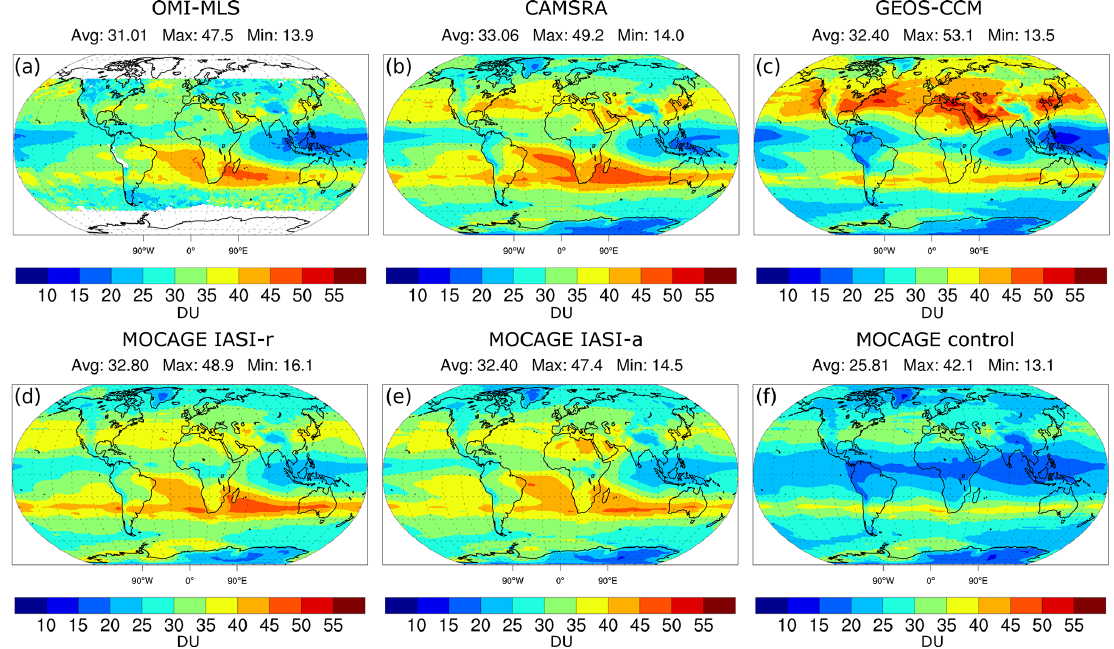
Figure 7. Tropospheric ozone column averaged over September–October–November 2010 from OMI-MLS retrievals (a) , CAMSRA reanal- ysis (b) , GEOS-CCM simulation (c) , IASI-r reanalysis (d) , IASI-a reanalysis (e) , and the MOCAGE control simulation (f) . Mean, minimum, and maximum values of ozone (in DU) are depicted over each